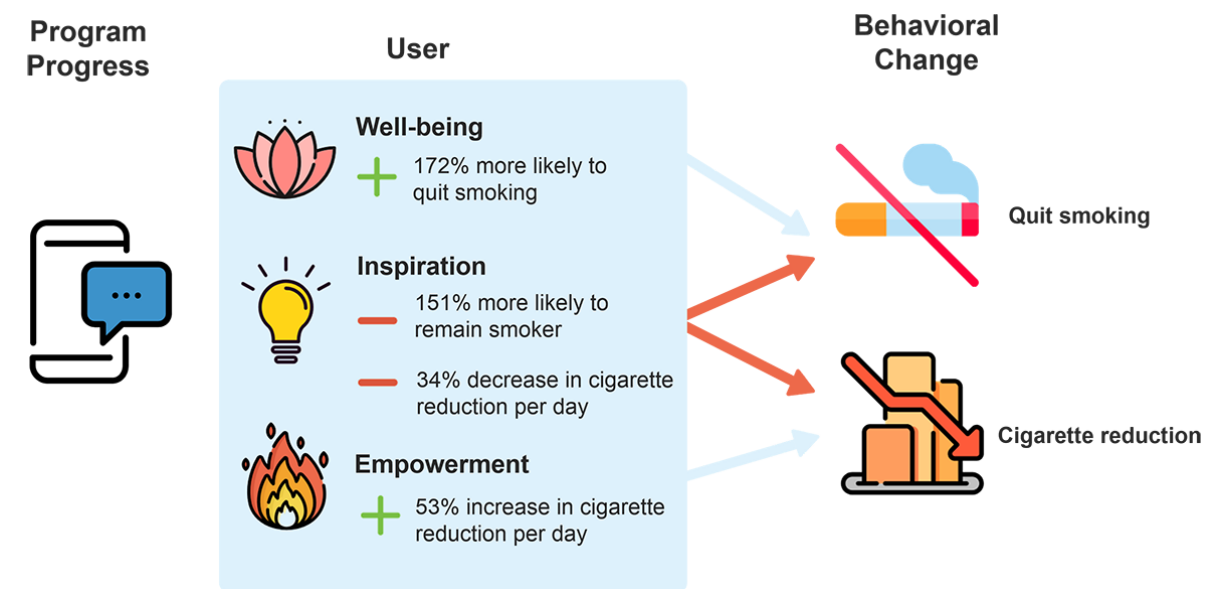
Figure 4. Main findings of this